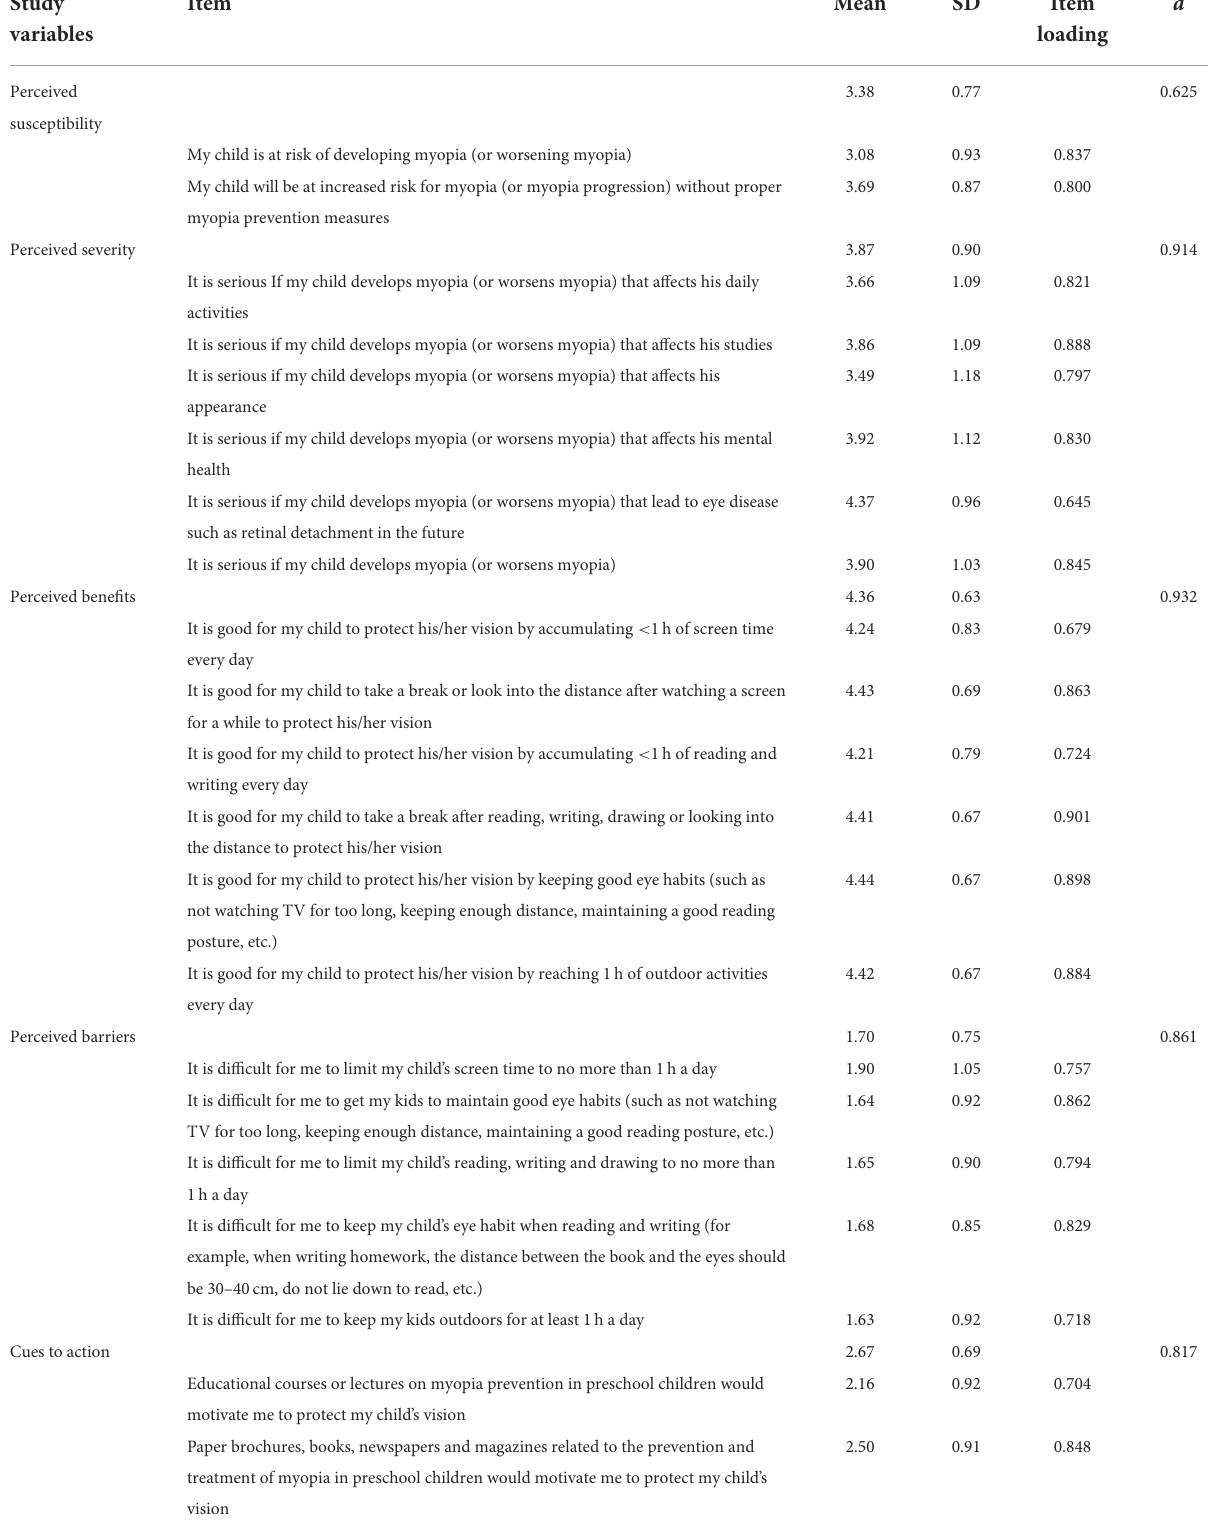
TABLE 1 Exploratory factor analysis, descriptive analysis and reliability of the HBM and TPB variables.